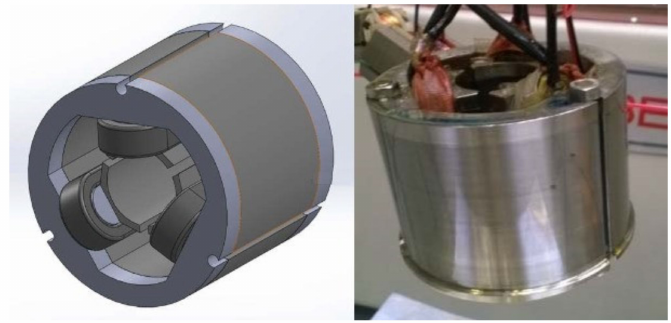
Figure 2. Three phase 40 W, 15,000 RPM motor using CNT concentrated windings